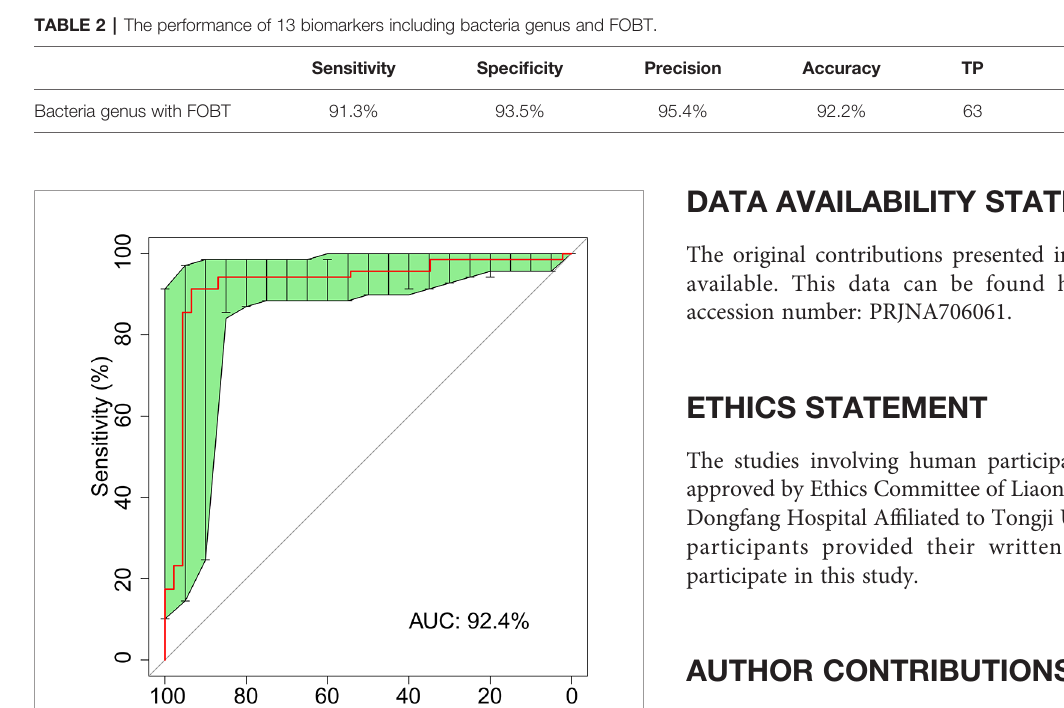
Supplementary Figure 1 | Venn diagram based on OTU. Each ellipse represents a group of samples. The overlapping area between the ellipses represents the shared OTU among the sample groups, and number of each block indicates the number of common or unique OTU of the sample groups contained in the block. Supplementary Figure 2 | Rarefaction curves of CRC and control samples.